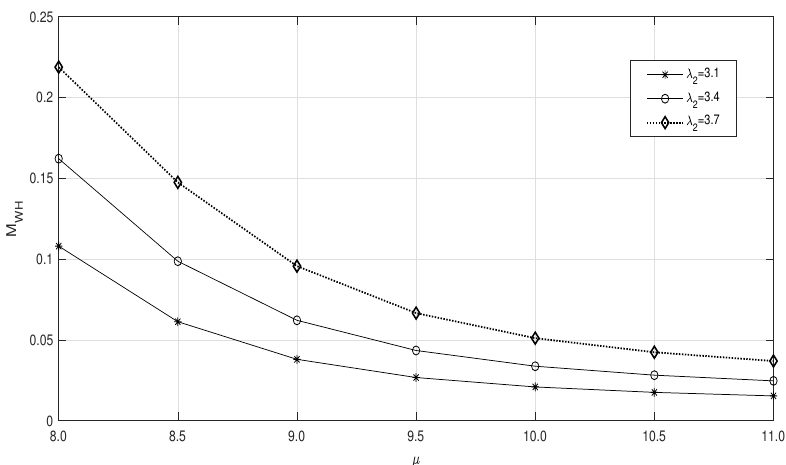
Figure 13. Mean number of customers in the waiting hall on λ 2 vs. µ .